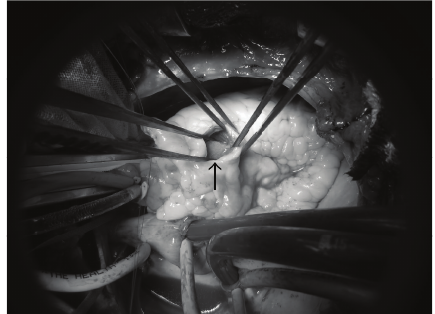
Figure 3: The tumor (black arrow) can be seen through an incision in the right ventricular free